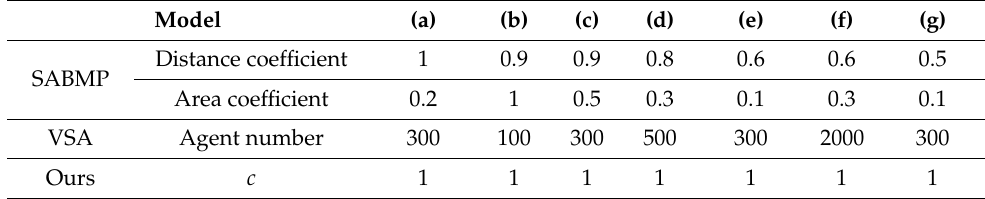
Table 3. Parameter configuration of different models.